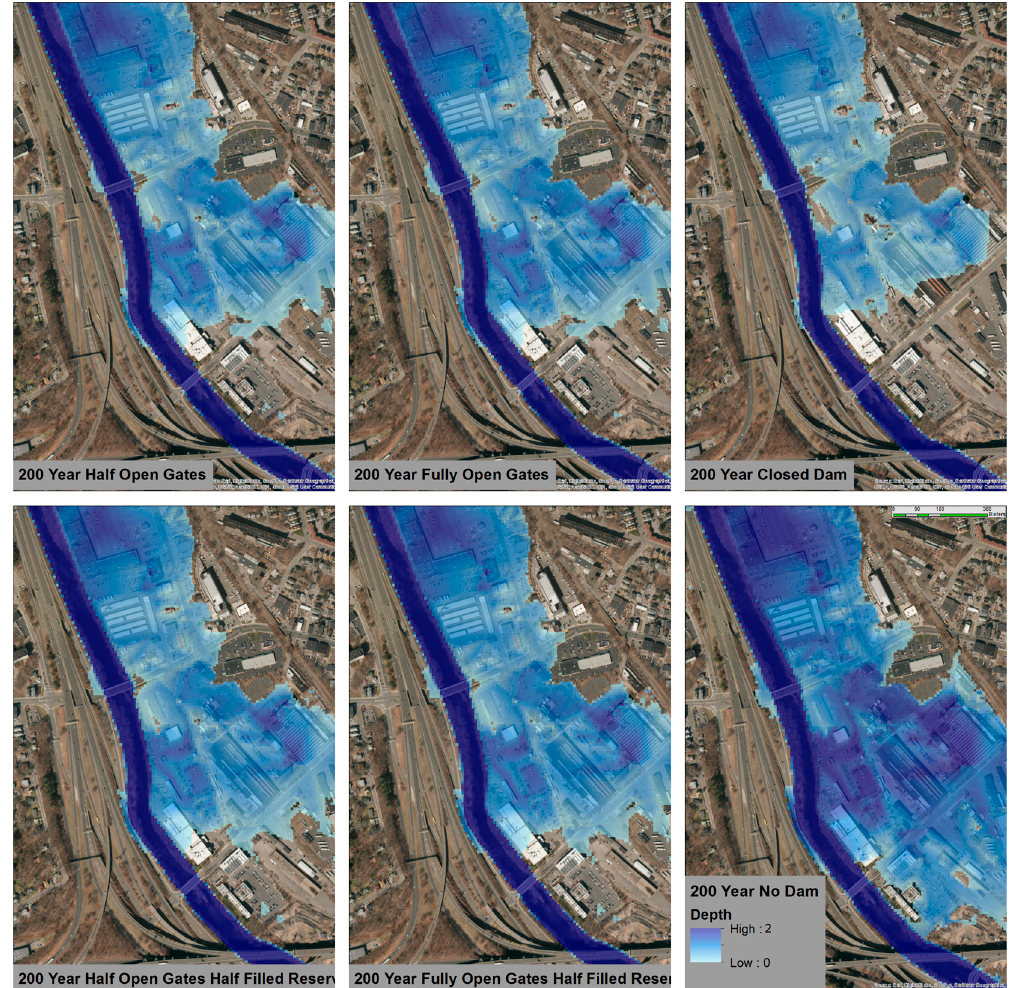
Figure 10. Simulated maximum 200-year flood inundation in various dam operation scenarios.